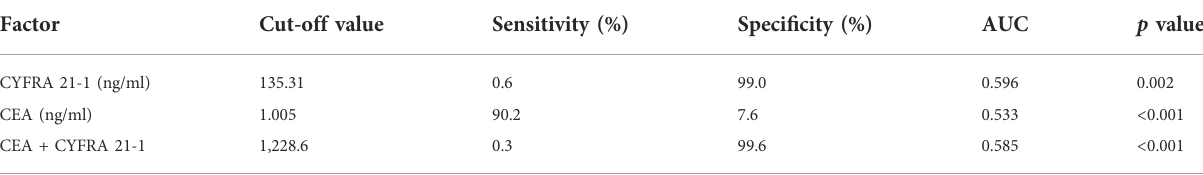
TABLE 4 Critical value, sensitivity, speci fi city and AUC of CEA and CYFRA 21-1 in lung cancer patients with mediastinal lymph node metastasis.